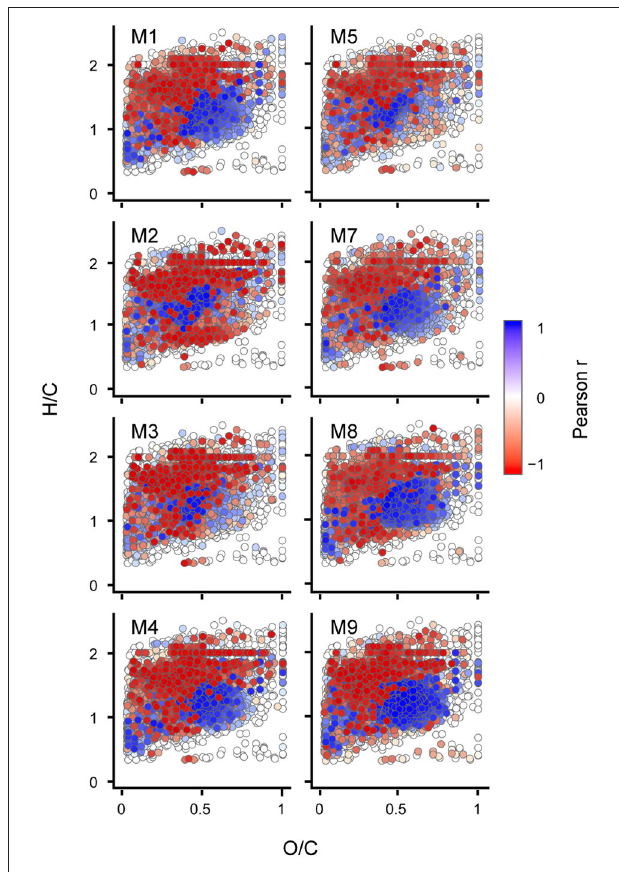
FIGURE 3 | Trends of individual molecular compounds displayed in van Krevelen space. Each dot represents one molecular formula ( n = 7,212). Pearson’s product-moment correlation of cumulative bacterial protein production (BPP) with relative signal intensities for the individual mesocosm units. The color displays the Pearson correlation coefficient ( r ) with values between − 1 (negative linear relation) and 1 (positive linear